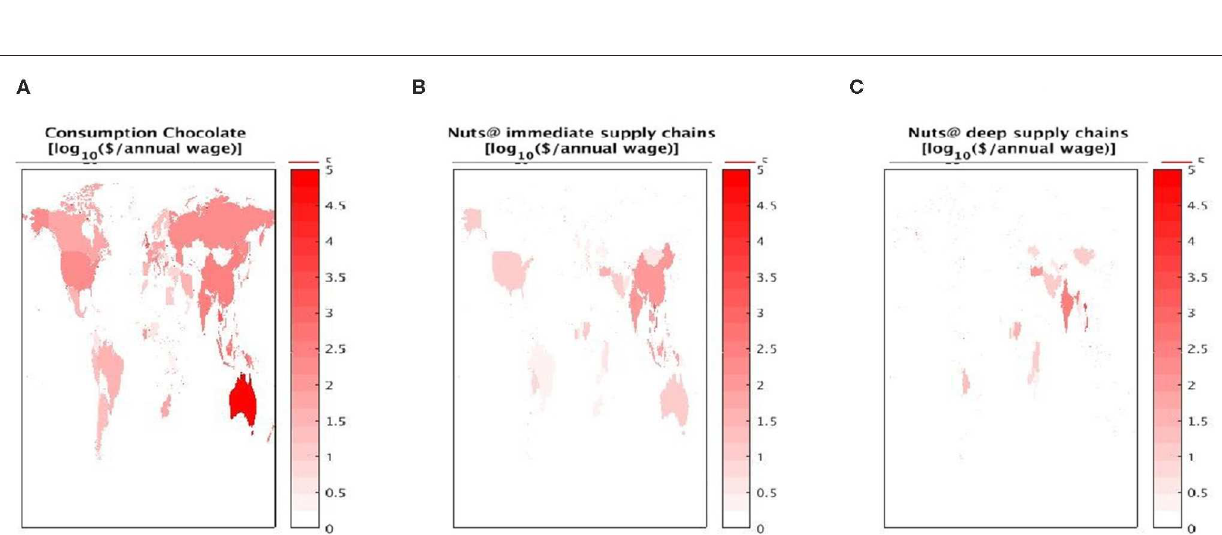
Frontiers in Sustainable Food Systems |